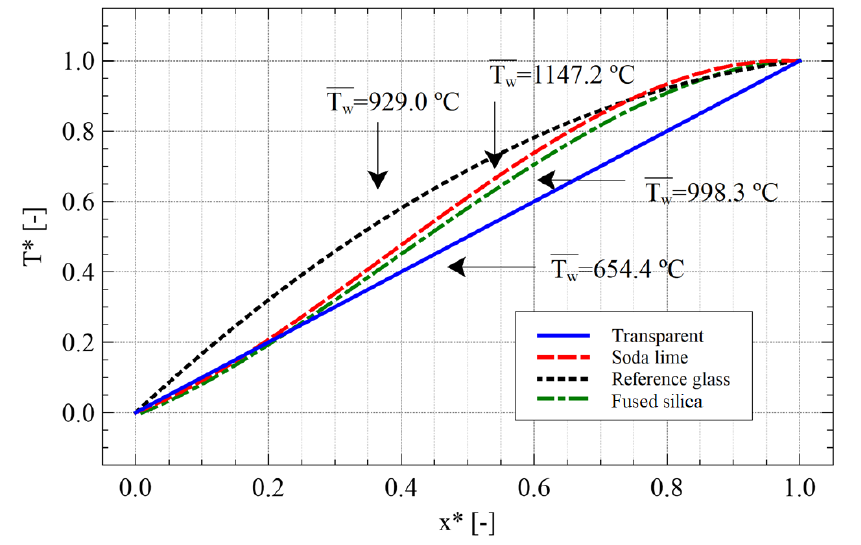
Figure 9. Temperature profiles for glass materials with different radiative properties.